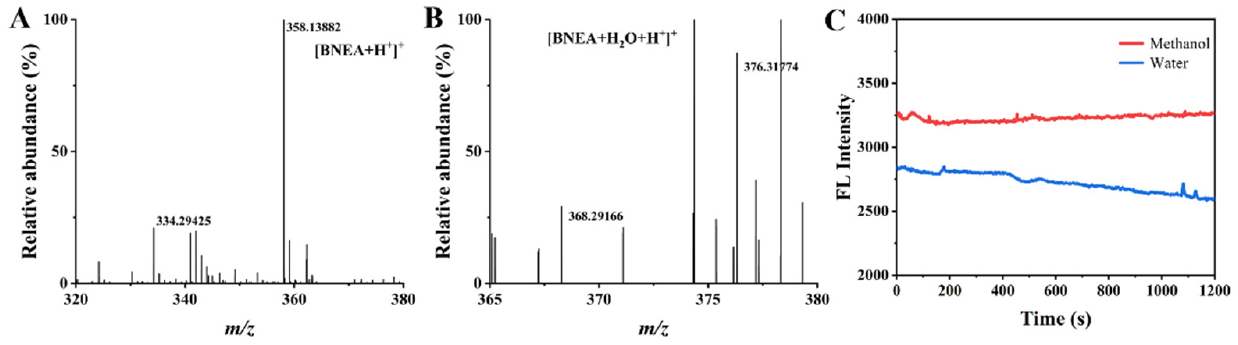
Figure 4. HRMS (ESI) spectra of ( A ) BNEA and ( B ) BNEA with H 2 O in methanol solution and ( C ) Fluorescence stability of BNEA in 99% methanol solution (V Methanol :V DMSO = 99:1) and 99% aqueous solution (V H2O :V DMSO = 99:1) ([BNEA] = 10 μ M) .